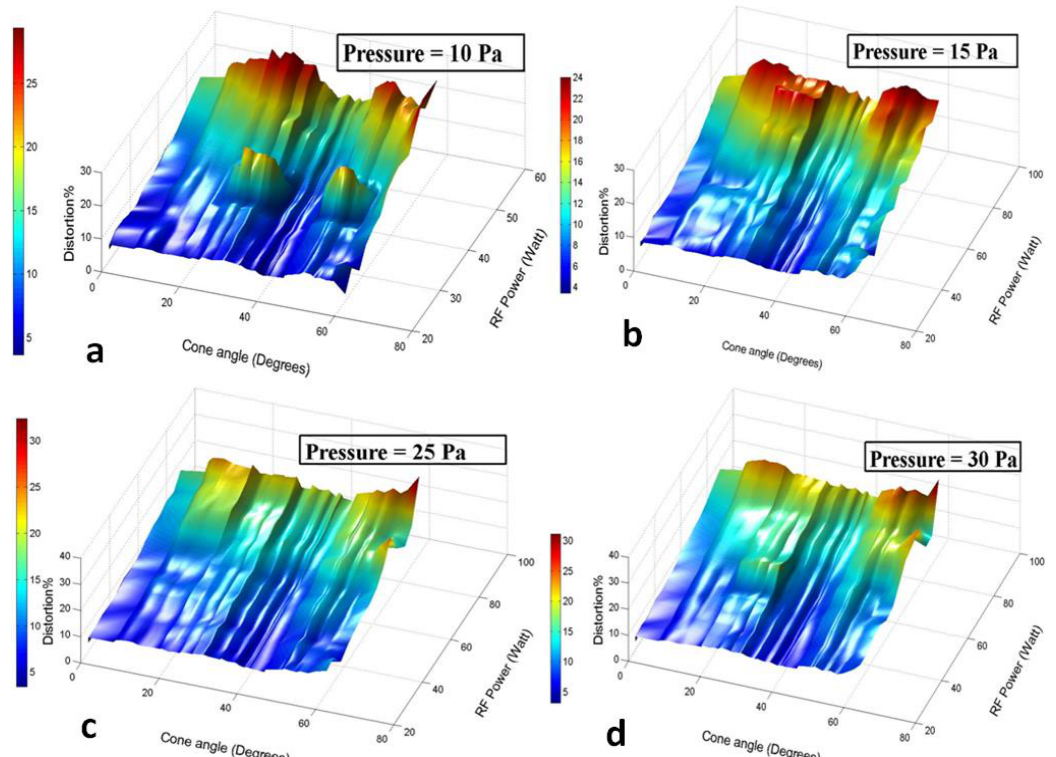
Fig.6: The distortion plotted against and RF power for four pressure values. a: 10 Pa, b: 15 Pa, c: 25 Pa, d: 30 Pa